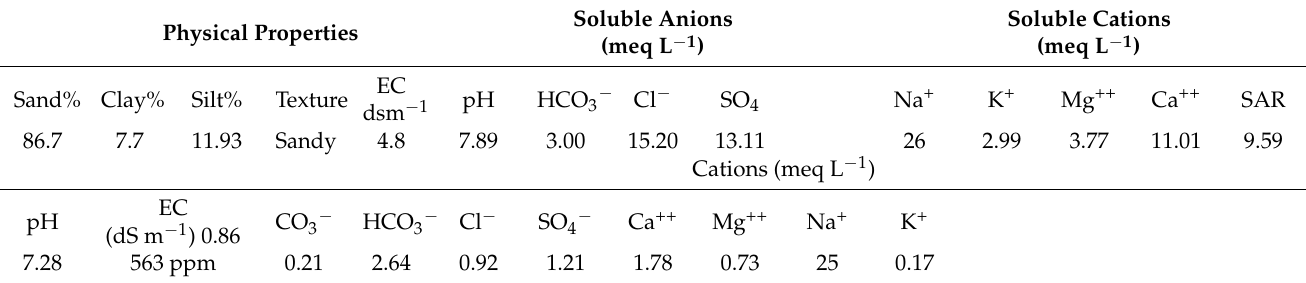
Table 9. Physical and chemical proprieties of the experimental soil and chemical study of drip irrigation. Physical